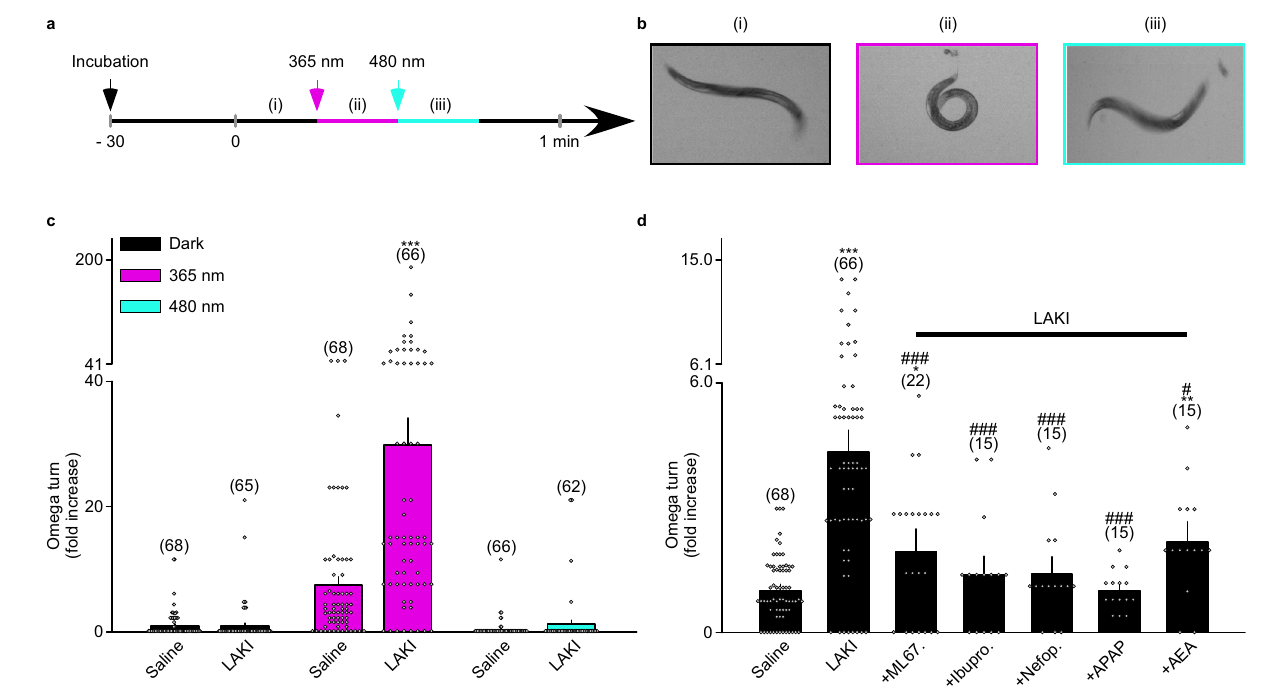
Fig. 5 | LAKI enables optical control of conserved pain pathways in C. elegans . a Schematic of the experimental behavioral assay. The black arrow represents the incubation of C. elegans in saline or 100 µ M LAKI solution. The Magenta arrow represents the beginning of 15s application of light at 365nm. The blue arrow representsthebeginningofthe15sapplicationoflightat480nm. b Representative observed behavior in the dark (i), then during 365nm light application (ii), and during 480nm light illumination (iii). c Graph summarizing the fold increase gen- erationofOmegaturnsunder365or480nmilluminationcomparedtothedark,in the presence of LAKI (100 µ M) or with saline solution. n was obtained from four independentexperiments.Statisticalsigni fi cancewasdetermined byQuasiPoisson GLMfollowedbyBonferroni ’ spost-test(*** p <0.001). d Bargraphsummarizingthe relativeaverageofOmegaturnsmadeeitherinthepresenceofLAKI(100 µ M),LAKI